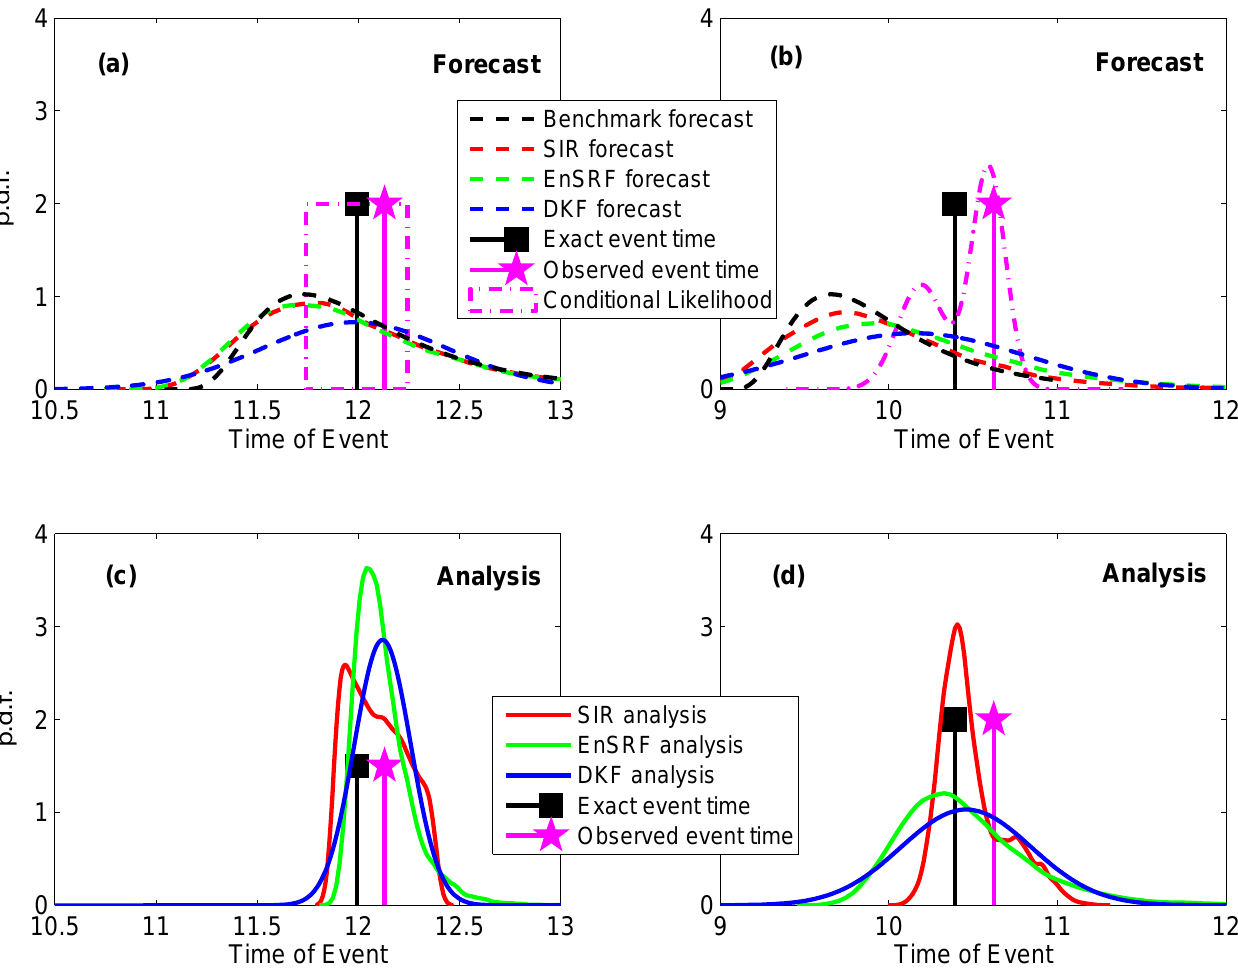
Fig. 2. Illustration of the data assimilation cycle for event 11. Forecasts of the SIR, EnSRF and DKF filters, and the benchmark, which ignores measurement errors, are shown in (a) and (b) for the case of uniformly and Gaussian mixture distributed measurement errors, respectively. Analyses (posteriors) are shown in (c) and (d) on the same